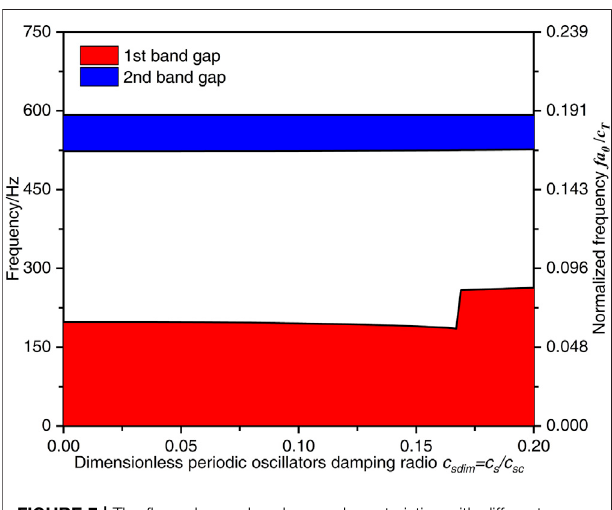
FIGURE 7 | The fl exural wave band gaps characteristics with different dimensionless periodic oscillators damping ratio c sdim